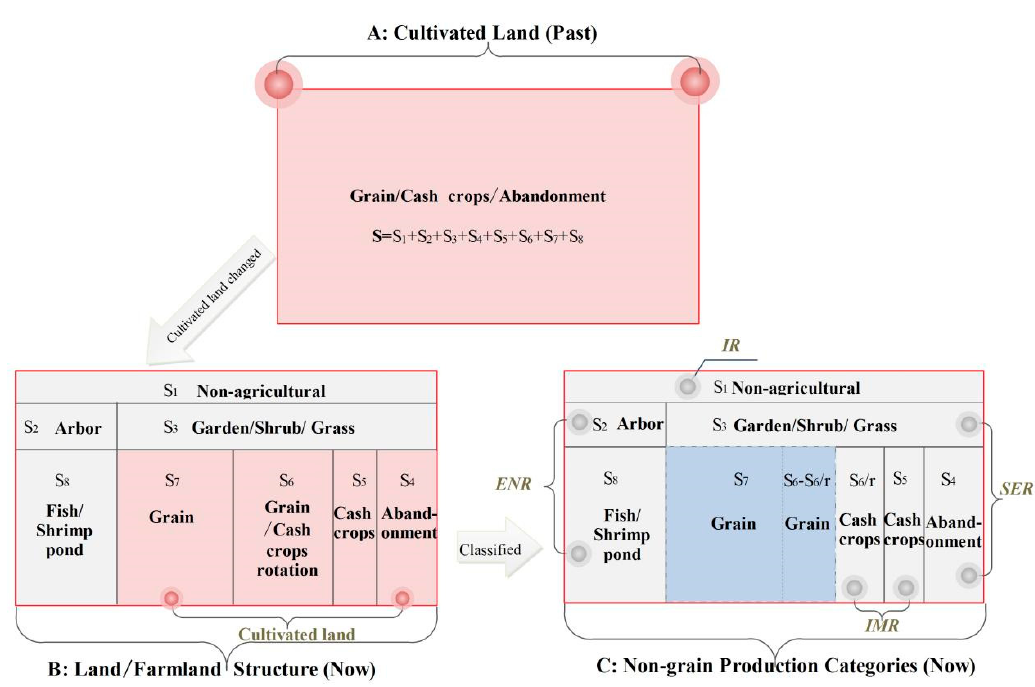
Figure 3. Method for classifying non-grain production categories.